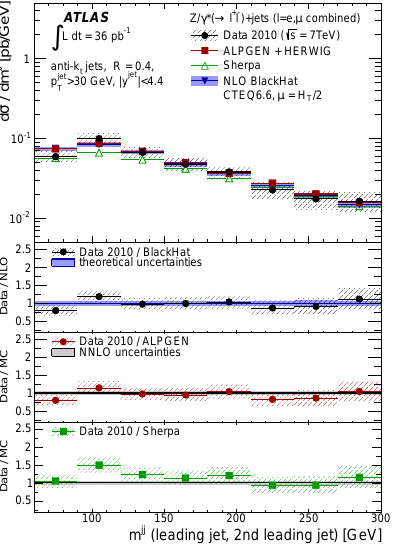
Fig. 3. Inclusive jet cross section in Z / γ ∗ ( tion normalized by Drell-Yan cross section as a function of p T .